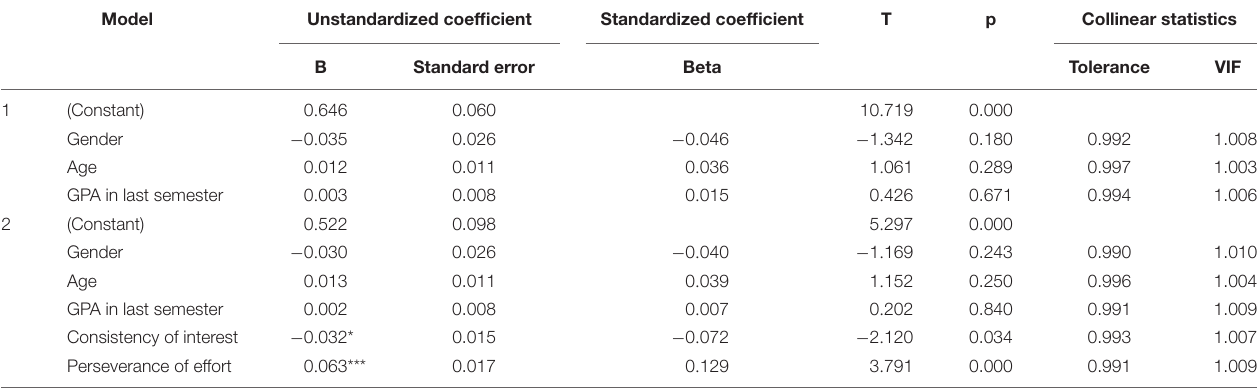
TABLE 2 | Results of regression analysis toward job-search intensity.